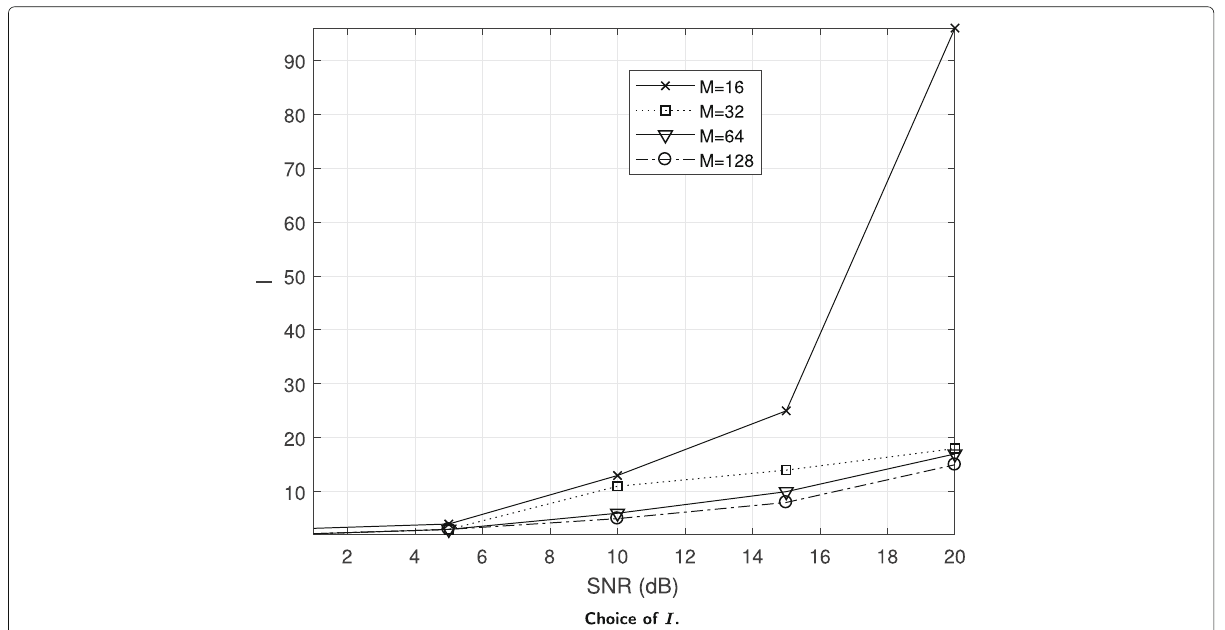
Fig. 4 Choice of I . Optimal I for both SPC and JPC methods and various values of M = M 1 = M 2 using ULA with N r = 16, N t = 4. UMi LOS